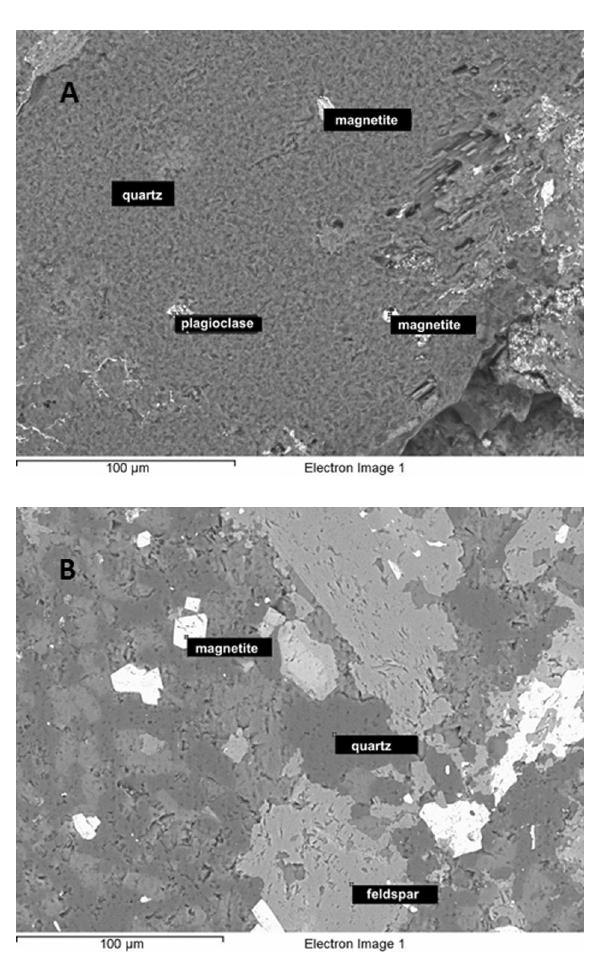
Fig. 4. Suursaari quartz porphyry: magnetite, orthoclase and plagioclase inclusions in quartz phenocryst. Sample S-32, M(cid:228)kiinp(cid:228)(cid:228)llys. Quartz phenocrysts in Suursaari quartz porphyrite contain some accessory minerals: magnetite ( A , B ), feldspar ( B ) and plagioclase ( A ). Scanning electron microscope (SEM)